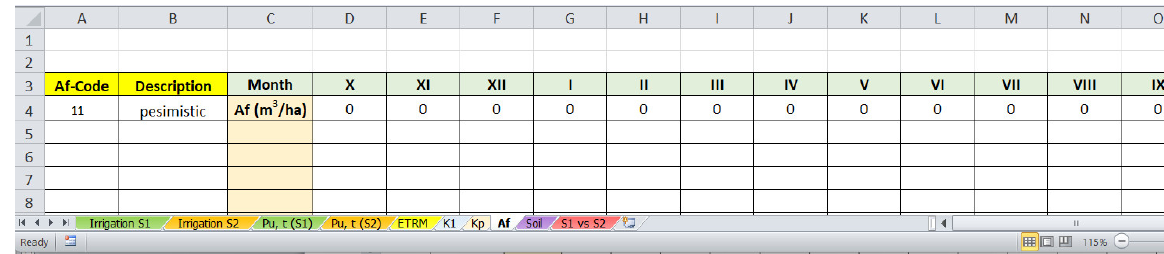
Figure 9. The “Af” worksheet.